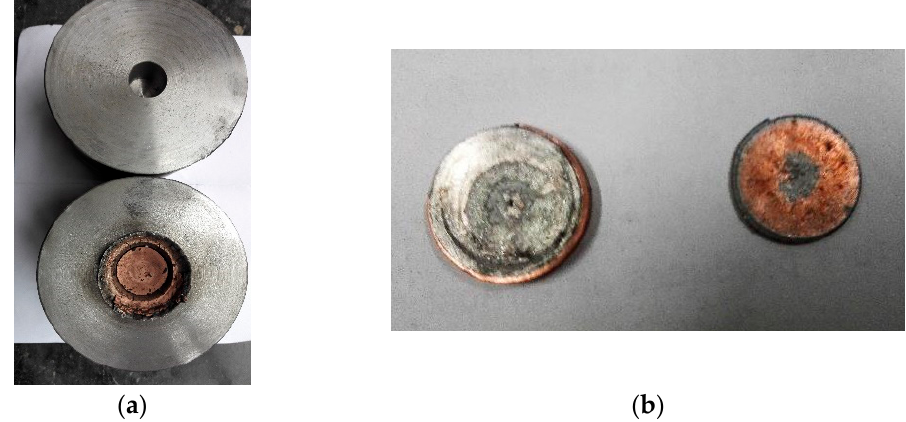
Figure 3. Copper recovery capsule ( a ), copper-coated sample ( b ) after undergoing shock wave load- ing.